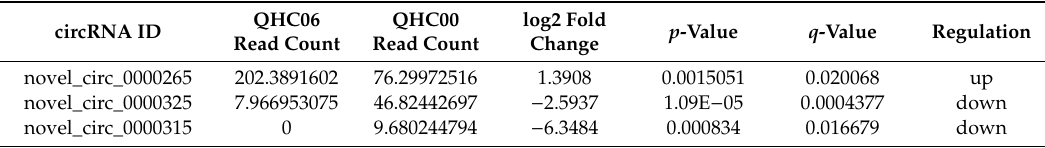
Table 3. The detailed information of DE